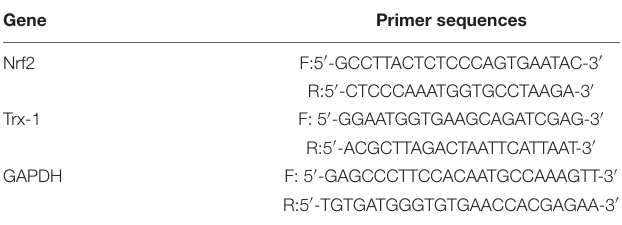
TABLE 1 | PCR primer sequences.